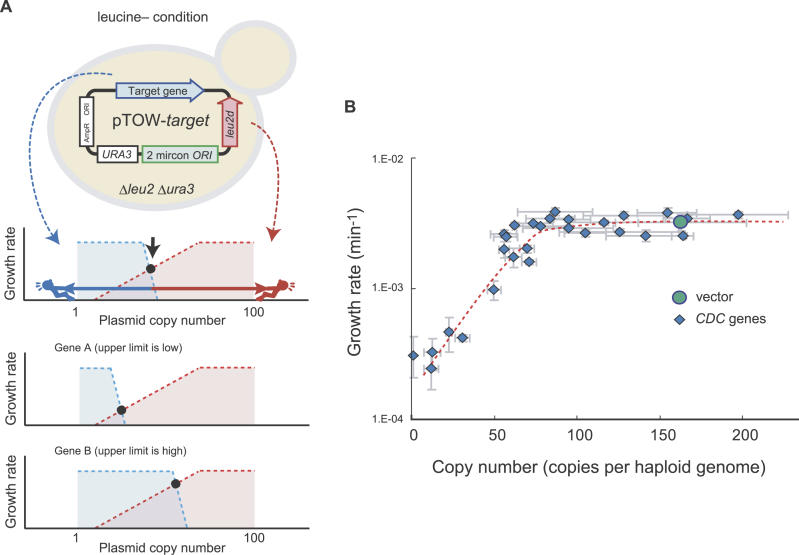
gTOW Is a Genetic Selection Method That Determines the Upper Limit Copy Number of Target Genes(A) Principle of the gTOW method. The cells with plasmid copy number close to the upper limit of each target gene are concentrated because of the genetic tug-of-war that emerges due to the high copy selection bias due to leu2d and the low copy selection bias due to the target gene. See text for details.(B) A scatter plot shows the correlation of maximum growth rates and plasmid copy numbers of each CDC gene determined in the gTOW experiment. The data used in the graphs are listed in Tables S1 and S2.